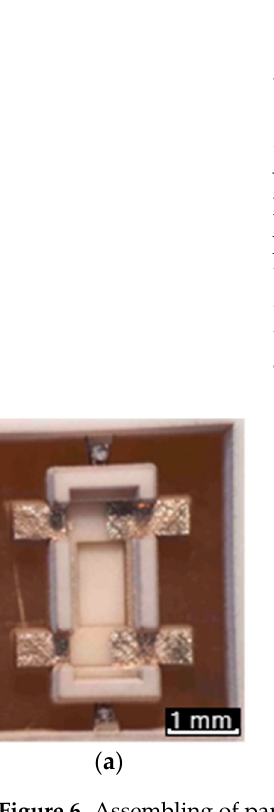
Figure 6. Assembling of parts of a sensor to form the SMD package SOT-23: ( a ) Bottom parts of gas sensor package after laser micromilling and Ag metallization deposition, ( b ) deposition of Ag-Pt paste on bottom parts of gas sensor package for gluing the YSZ membrane with microhotplate; ( c ) deposition of Ag-Pt paste on the YSZ membrane with microhotplate for gluing top parts of the package; and ( d ) already assembled gas sensor after firing.